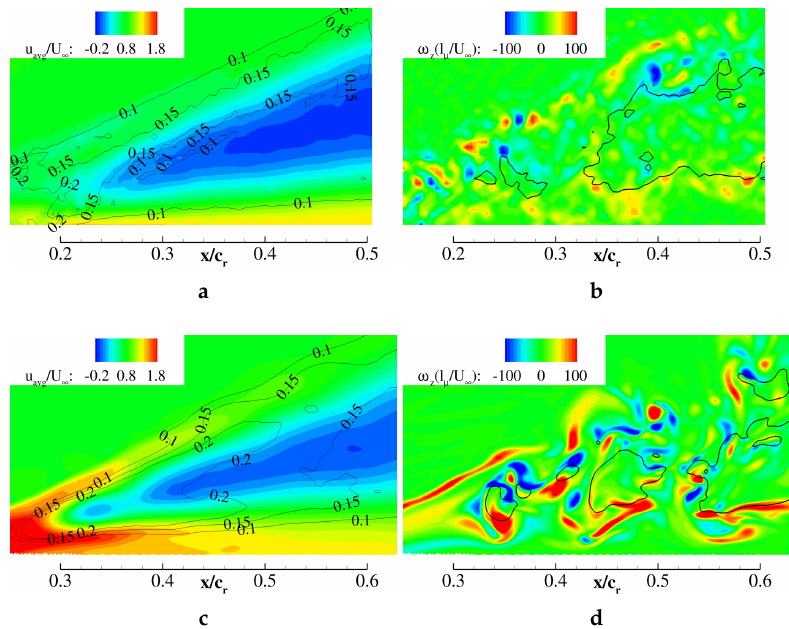
Figure 7. Plane along the vortex core, α = 35 ◦ , Re = 0.5 × 10 6 : ( a ) measured and ( c ) computed averaged axial velocity with k / U 2 ∞ isolines; ( b ) measured and ( d ) computed instantaneous in-plane vorticity with isolines representing u = 0. DES views ( c , d ) shifted by 0.1 in the relative chordwise and spanwise